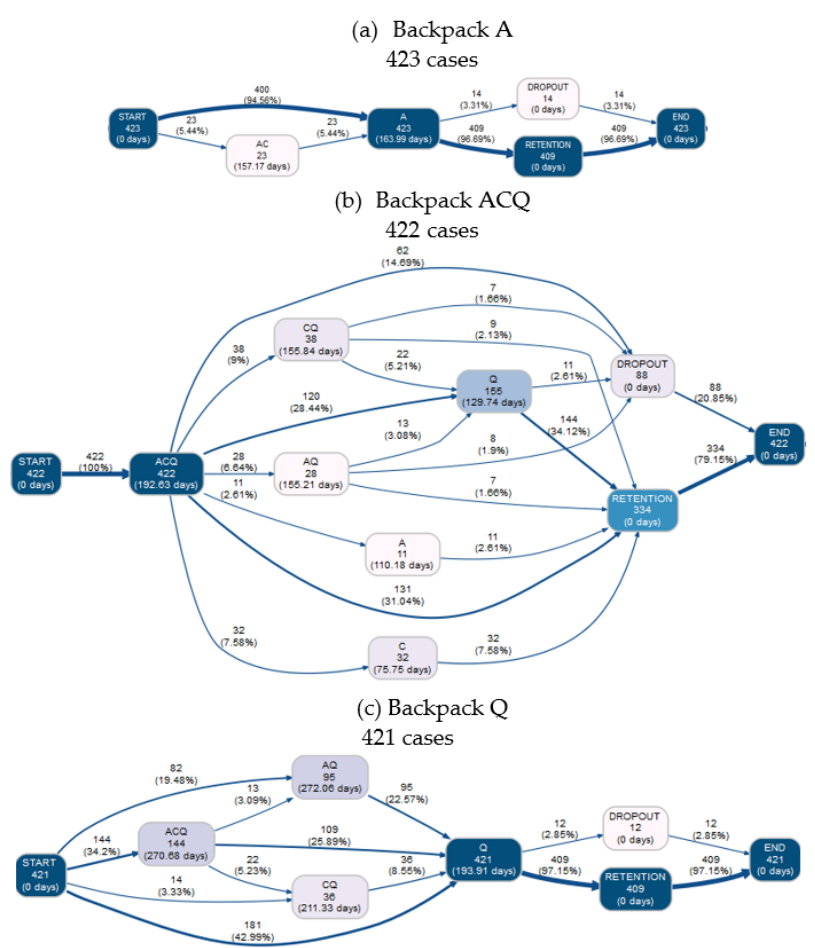
Figure 7. Educational trajectories, according to the BPPM model, which includes the three most frequent backpacks, showing only the most frequent variants, which correspond to 90% of the students in each case. ( a ) Shows backpack trajectories that include the A backpack. ( b ) Shows backpack trajectories that include the ACQ backpack. ( c ) Shows backpack trajectories that include the Q backpack. The darker color of the nodes represents a higher percentage of students who went through a state. The thickness of the arrows represents the percentage of students who had transitions between both states. All values are percentages in relation to the total number of students included in each model.